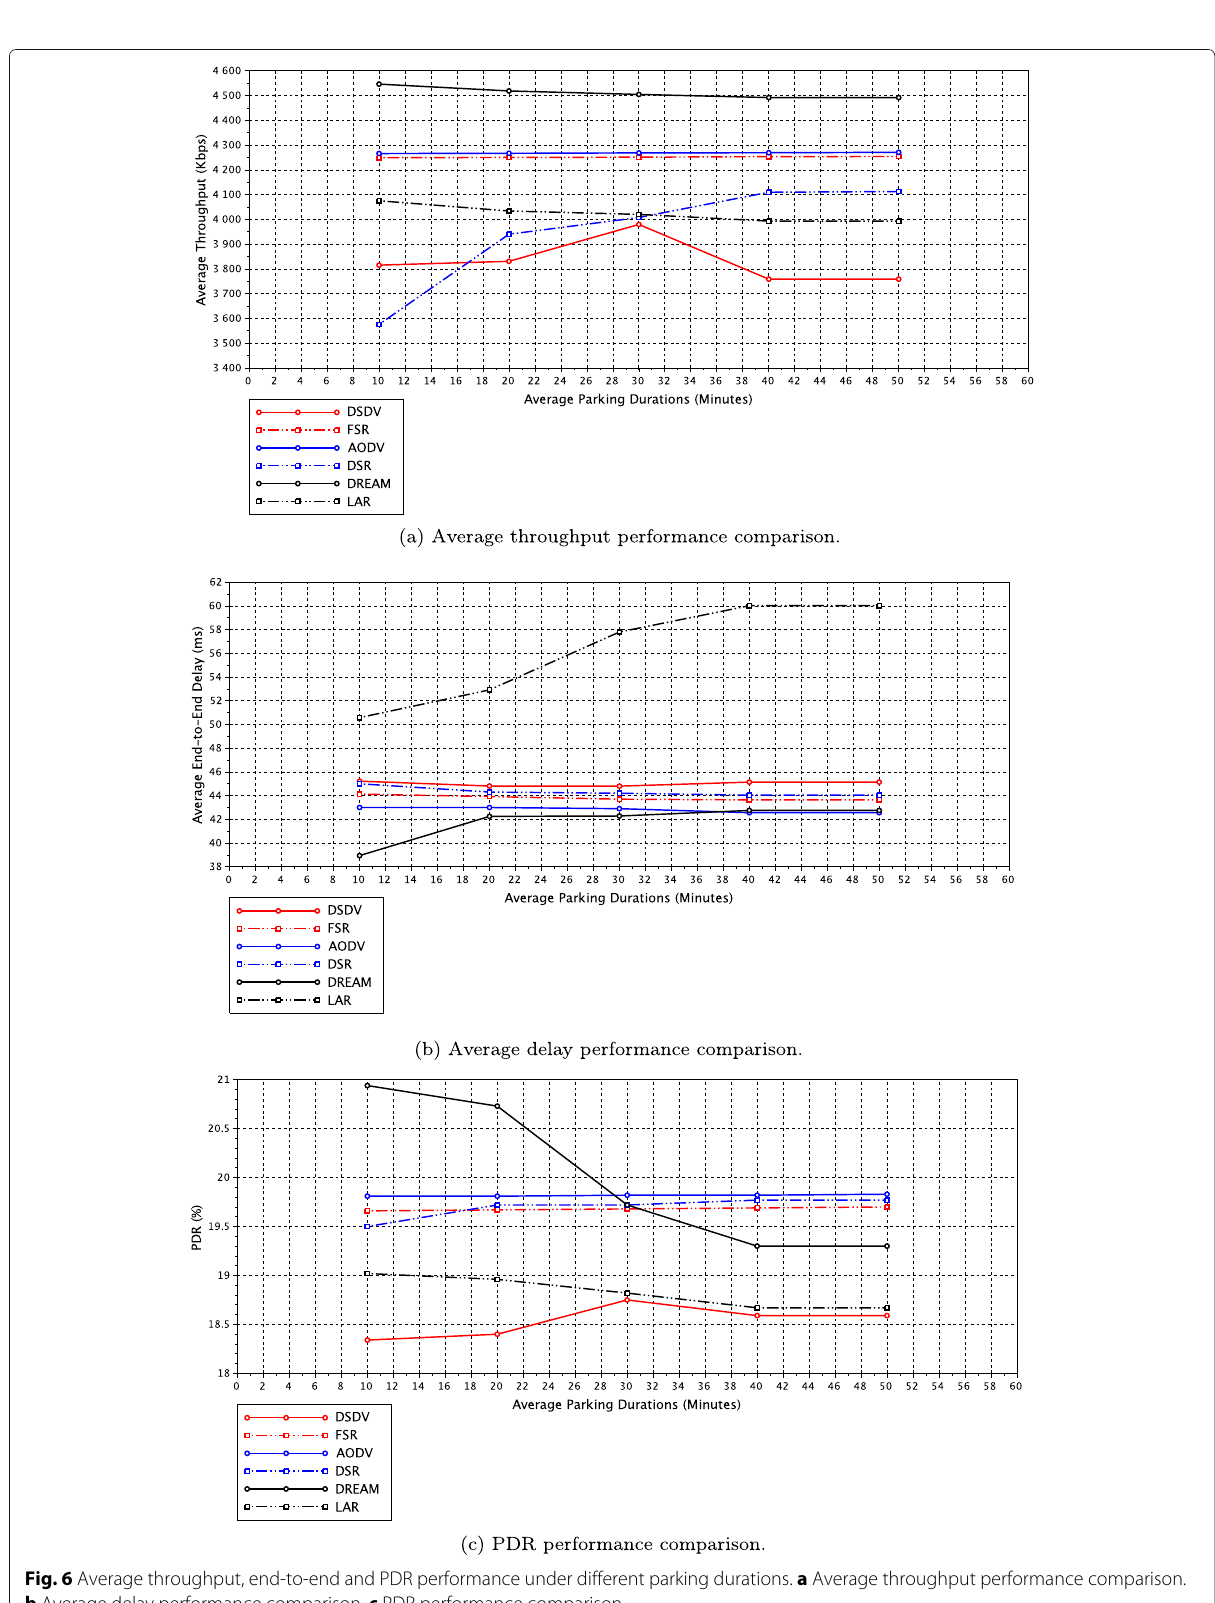
Fig. 6 Average throughput, end-to-end and PDR performance under different parking durations. a Average throughput performance comparison. b Average delay performance comparison. c PDR performance